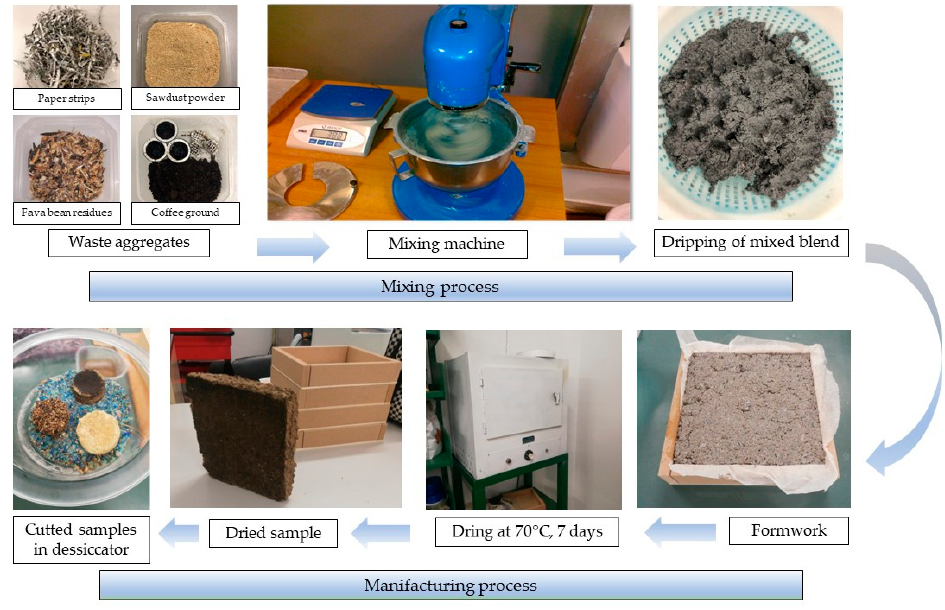
Figure 1. Production